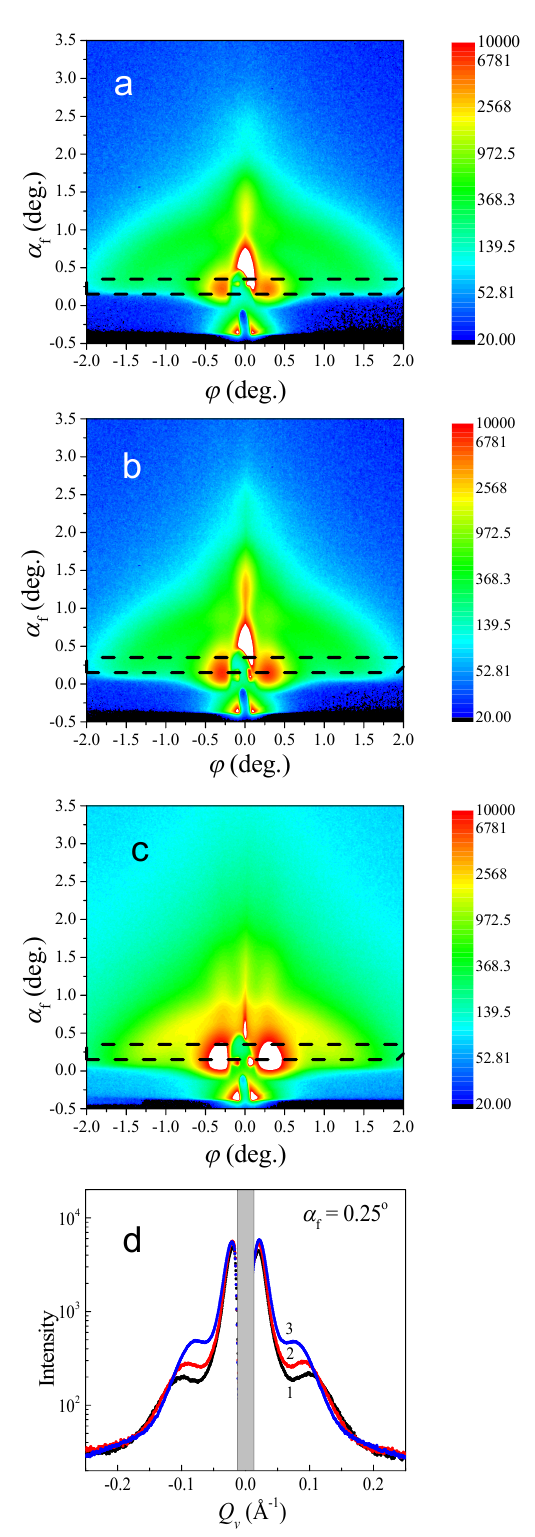
Figure 3. ( a ) The two-dimensional GISAXS intensity maps from the samples SiO 2 (38 at.% Co)/Si ( a ), SiO 2 (54 at.% Co)/Si ( b ), and SiO 2 (82 at.% Co)/Si ( c ). The dashed horizontal lines indicate the integration regions for the one-dimensional profiles shown on ( d ) panel. ( d ) The scattering intensity profiles along φ direction at α f = 0.25 ◦ for SiO 2 (38 at.% Co)/Si—curve 1, SiO 2 (54 at.% Co)/Si—curve 2, and SiO 2 (82 at.% Co)/Si—curve 3. The gray area corresponds to the beamstop